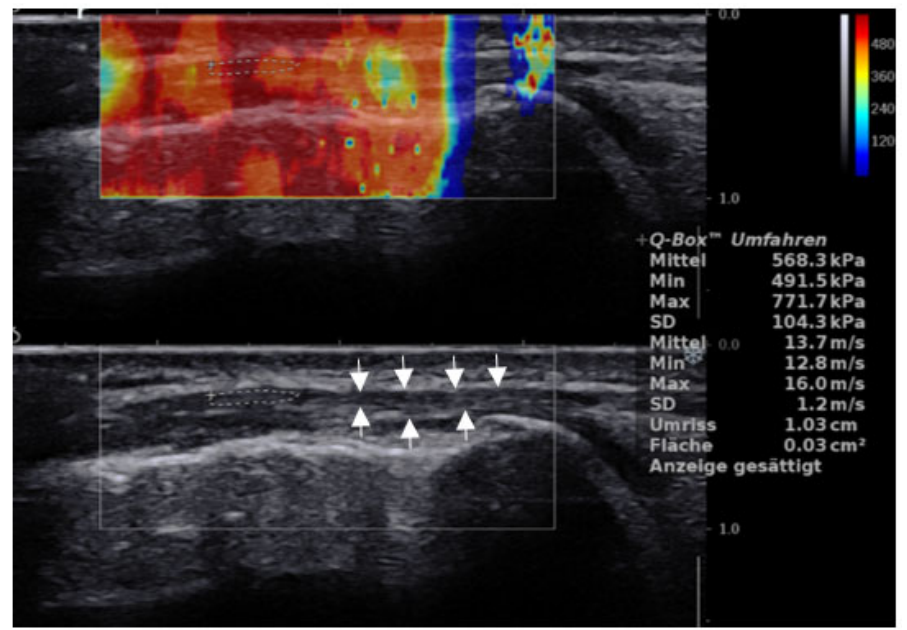
Figure 1. Longitudinal scan of the ITB. ROI shows measurement 2 cm proximal of the femoral condyle in a 29-year-old male patient with ITBS. Note: B mode US shows hypoechoic thickening and irregularity of the ITB (between arrows) with a mean of 13.7 m/s.